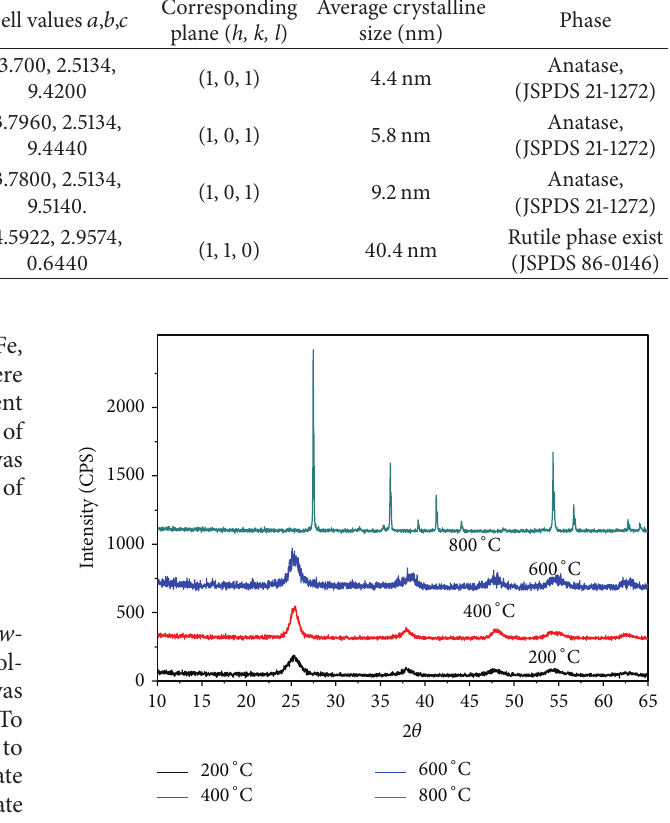
Figure 1: XRD of 1% TM doped TiO 2 for different